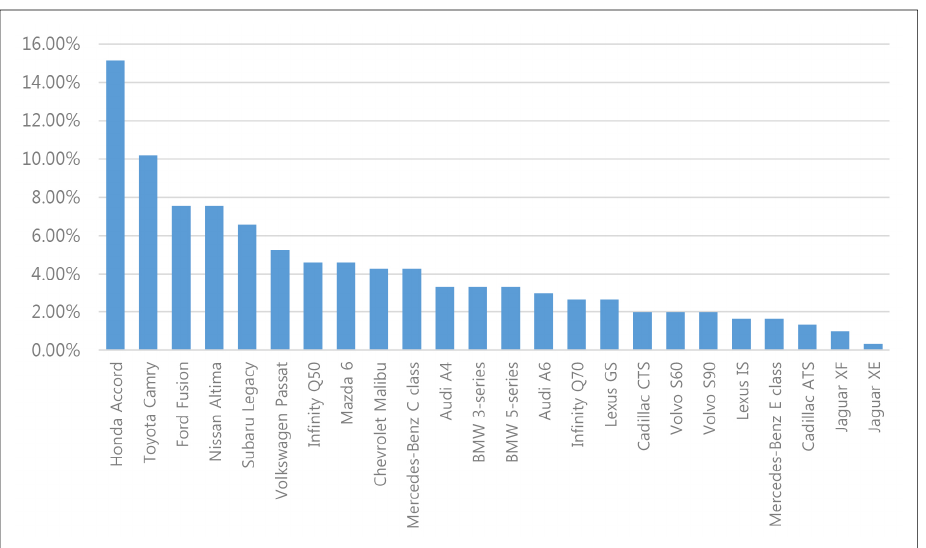
<Figure 9> Frequencies of brands compared with Genesis G80